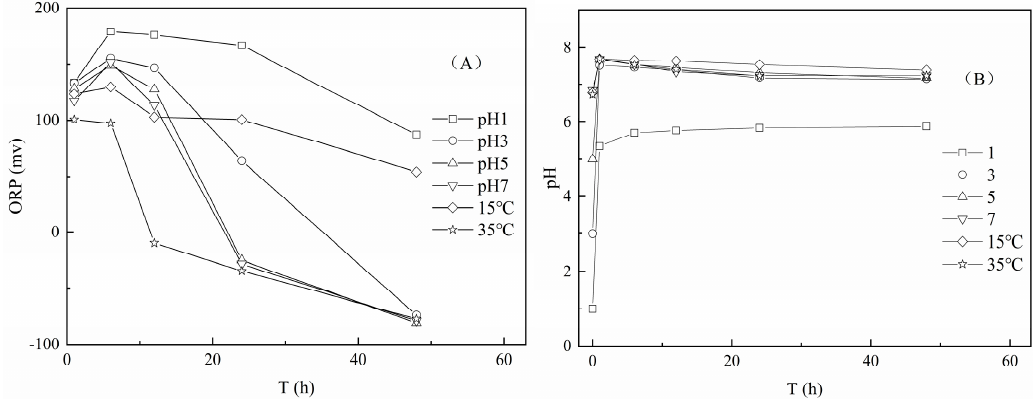
Figure 2. The Changes of ORP and pH values in leachate under the different conditions (( A ): redox potential (ORP); ( B ): pH).